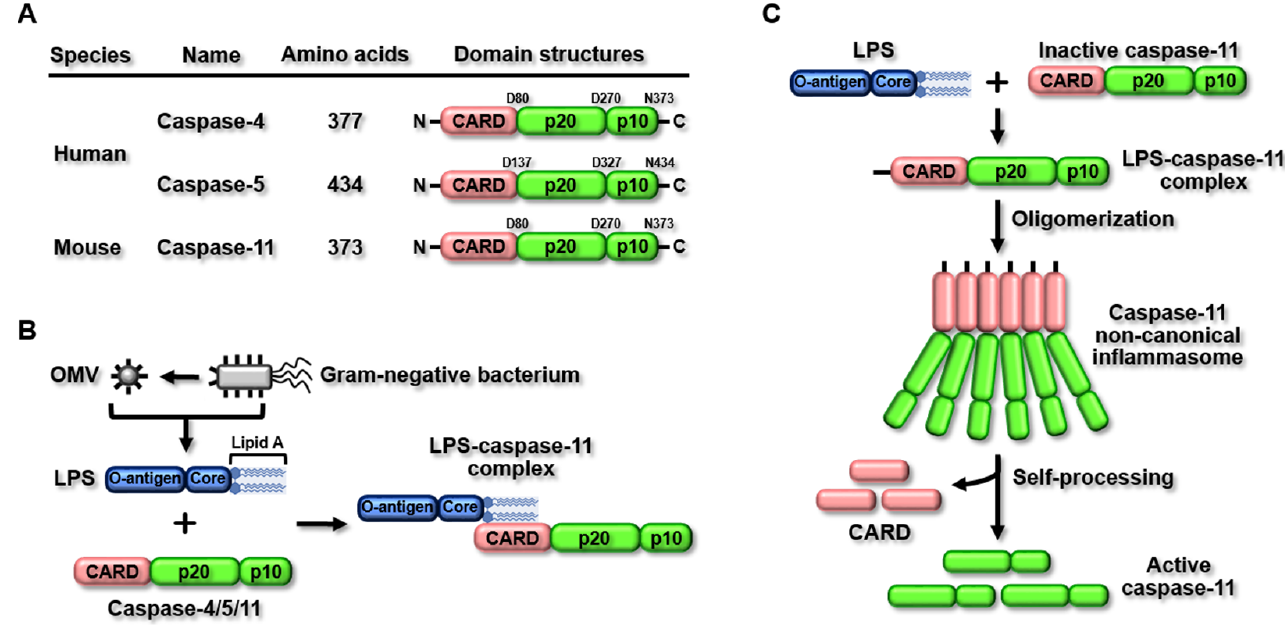
Figure 1. Structure and activation of the caspase-11 non-canonical inflammasome. ( A ) Human caspase-4, caspase-5, and mouse caspase-11 have similar domain structures, consisting of an N- terminal CARD, a p20 large catalytic domain, and a C-terminal p10 small catalytic domain. ( B ) Sensing LPS by caspase-11. Caspase-11 recognizes LPS by direct interaction between caspase-11 CARD with LPS lipid A. ( C ) Activation of the caspase-11 non-canonical inflammasome. Direct interaction